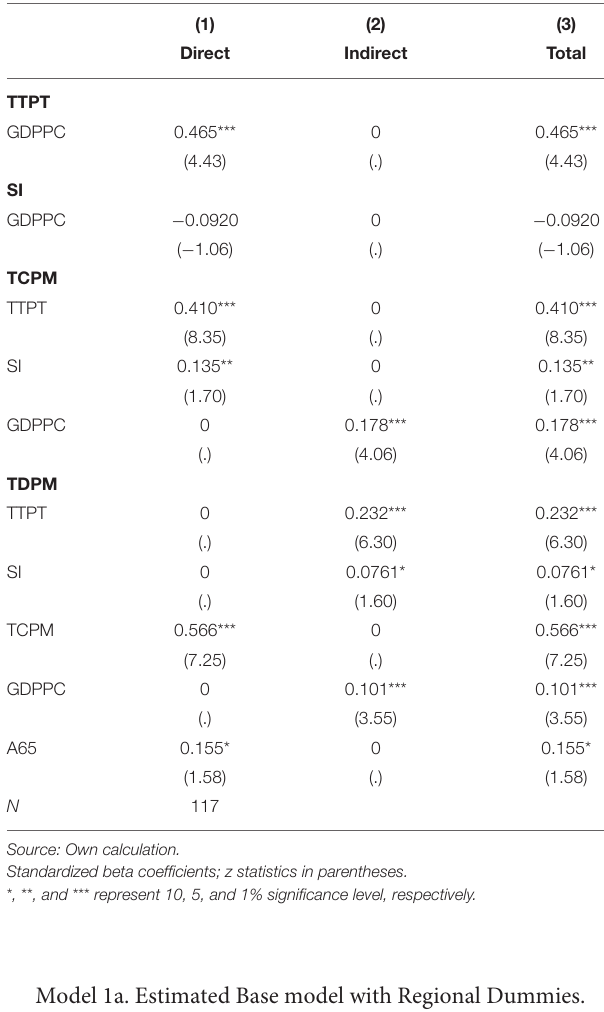
TABLE 6 | Direct, indirect, and total effects for the base model with regional dummies.